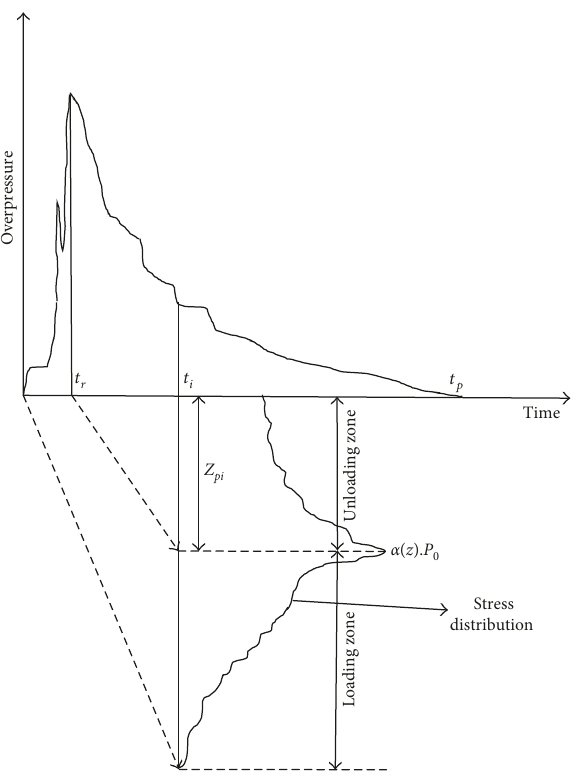
Figure 1: Schematic representation of dilatational stress distri- bution in ground at time t i .